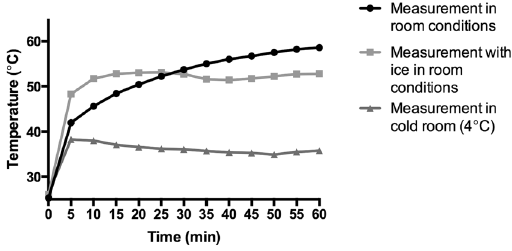
Figure 3. Temperature rises rapidly inside the blue light instrument during operation. Incubating samples on ice within the instrument is insufficient to reduce this effect, but housing the instrument within a cold room (at 4° C) during treatment maintains sample temperatures at 37 °C.